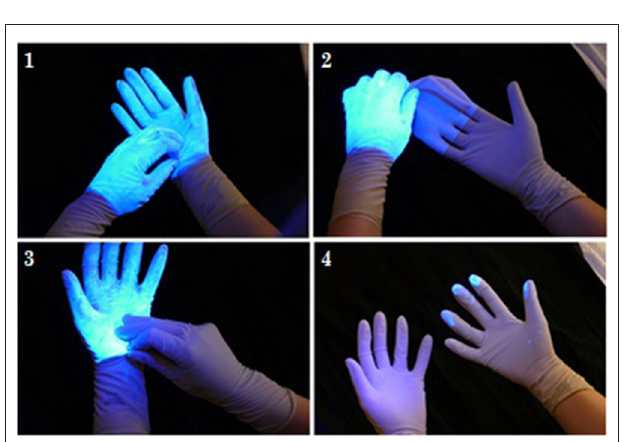
FIGURE 4 | An example of how direct contamination can occur. The clean outer surface of a fresh top glove can touch the outer surface of a contaminated